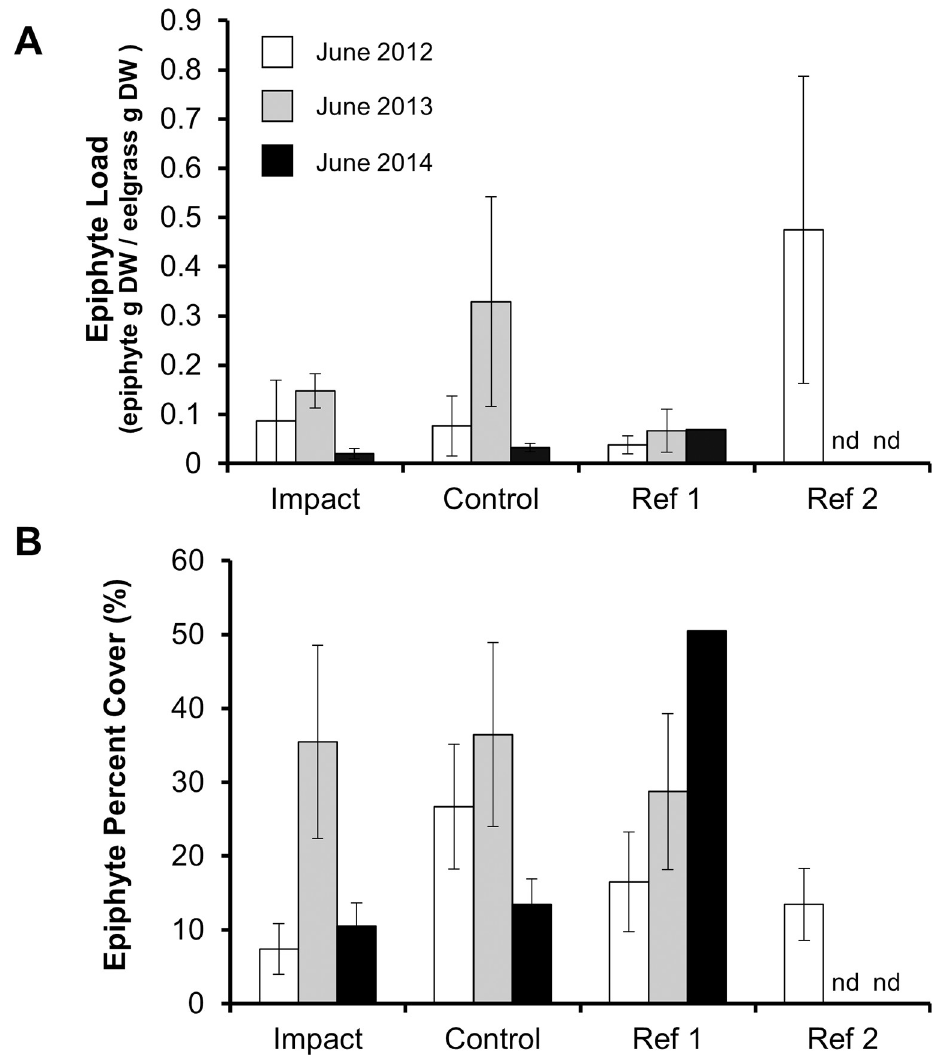
Fig 7. Mean epiphyte load (A) and percent cover (B) in each location each year. Values represent means with 95% confidence intervals; n = 5 samples when eelgrass shoots were present. Reference beds not included in analysis but included here for comparison. nd = No